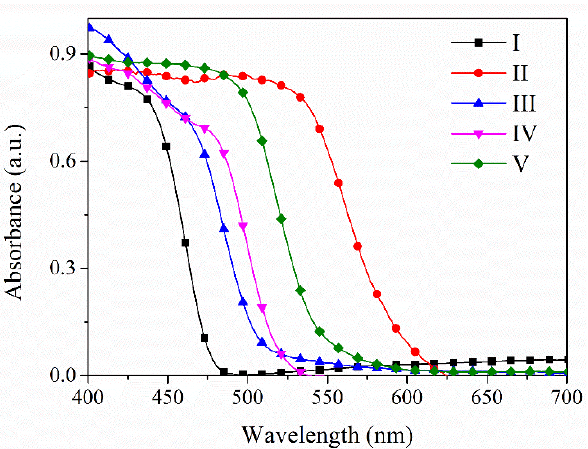
Molecules 2021 , 26 , x FOR PEER REVIEW 13 of 34 Figure 7. Absorbance spectra of compounds I – V in solid state at room temperature.